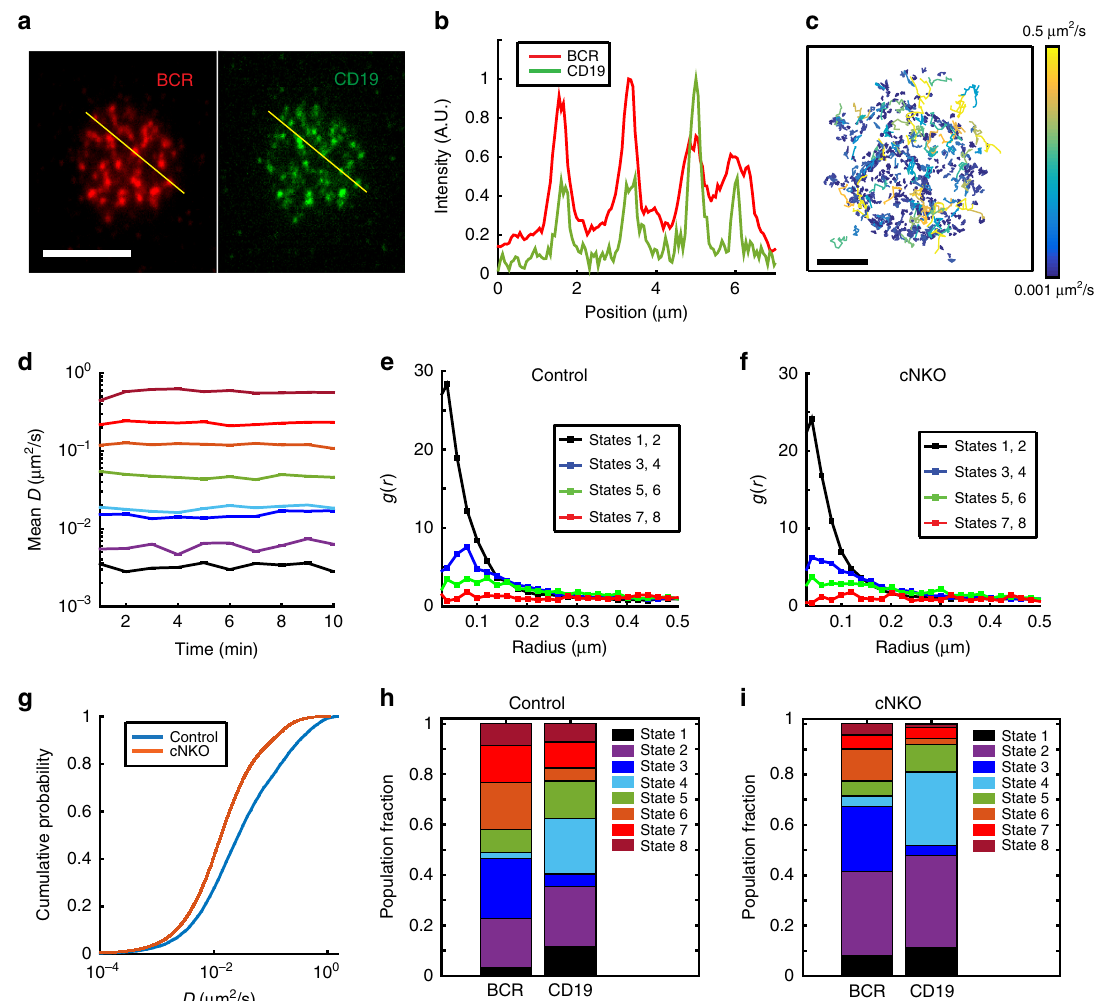
Fig. 5 N-WASP expression modulates CD19 diffusivity. a Instant SIM images of activated B cell, showing that AF546 labeled BCR (red) and AF488 labeled CD19 (green) reside in clusters that colocalize to within the ~150 nm resolution limit. Scale bar is 5 μ m. b Intensity pro fi les for BCR (red) and CD19 (green) fl uorescence along the yellow lines as drawn in a . c Compilation of CD19 tracks over a 10-min period in an activated control B cell. Scale bar is 1 μ m. d Plot showing the mean diffusivity of each of the eight diffusive states obtained from pEM analysis as a function of time. The colors corresponding to the different states are as shown in h . Error bars represent the standard error of the mean. e , f Pair correlation function plot for all states for control and N- WASP-KO cells respectively. g Cumulative Probability distribution of diffusivities showing that mobility of CD19 in cNKO cells is signi fi cantly lower than in control cells (control cells N = 10, cNKO cells N = 11, p = 0.0013 Kruskal – Wallis test). h , i Comparison of population fractions of BCR and CD19 in different states for control and cNKO cells, respectively. Source data are provided as a Source Data fi